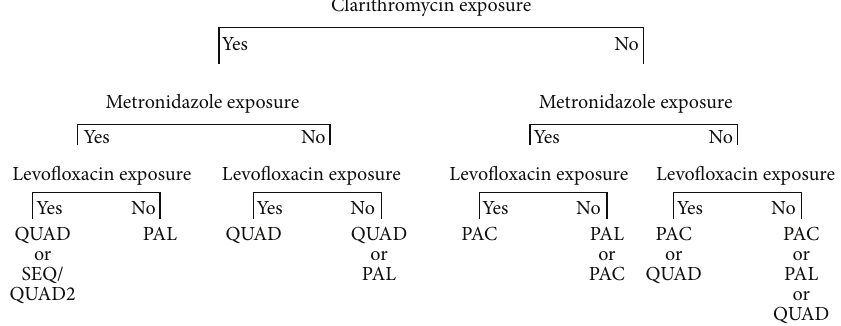
Figure 1: Treatment algorithm based on prior antibiotic exposure. QUAD: a twice daily proton pump inhibitor (PPI) given with four times daily metronidazole 500 mg, tetracycline 500 mg, and peptobismol 2 tablets; SEQ: a PPI and amoxicillin 1000 mg for 5 days followed by the PPI, metronidazole 500 mg, and clarithromycin 500 mg, for the subsequent 5 days, all given twice daily; QUAD2: a PPI and clarithromycin 500 mg both given twice daily along with levofloxacin 500 mg daily and peptobismol 2 tables four times a day; PAL: a PPI and amoxicillin 1000 mg, both twice daily given with levofloxacin 500 mg once daily; PAC: a PPI, amoxicillin 1000 mg and clarithromycin 500 mg, all given twice daily. In case of penicillin allergy: PAC was replaced by PMC (a PPI, metronidazole 500 mg, and clarithromycin 500mg, all given BID) unlesspreviousexposuretometronidazole,andPALwasreplacedbyPCL(aPPIandclarithromycin500 mg,bothBIDgivenwithlevofloxacin 500 mg once daily) unless previous exposure to